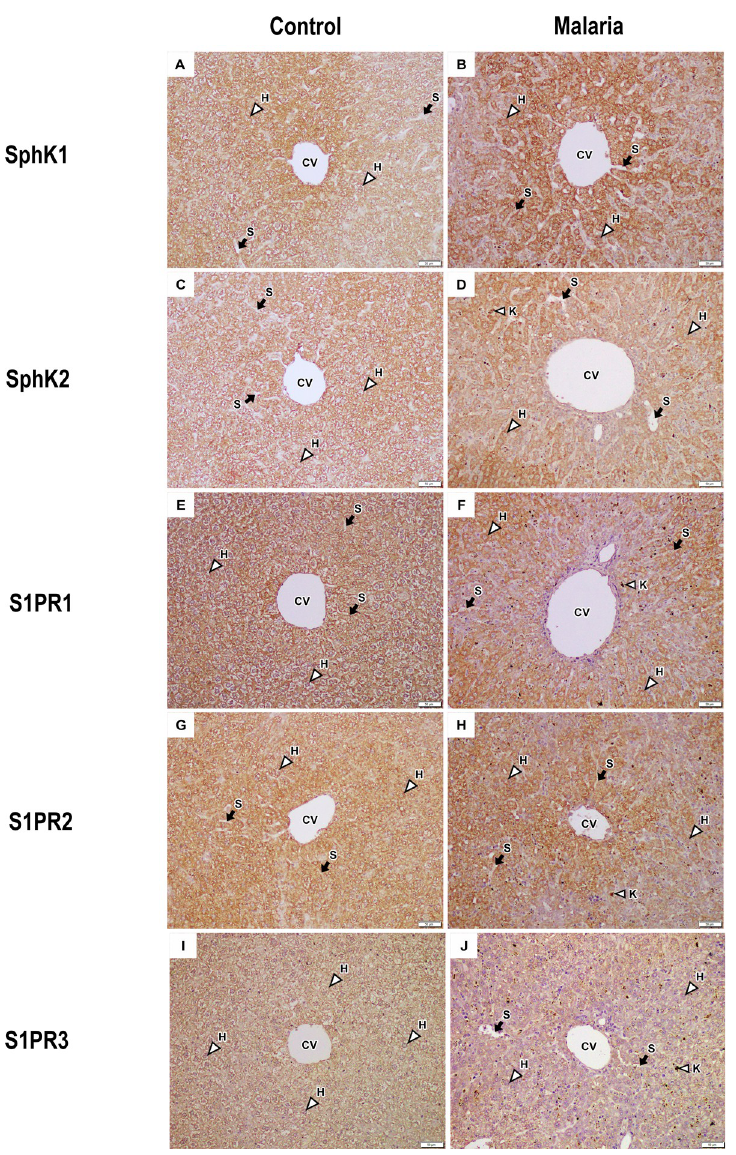
Fig 2. Immunoperoxidase staining for SphK and S1PR in liver tissues from control (A, C, E, G, I) and PbA- infected mice (B, D, F, H, J). Hepatocytes (H), Kupffer cells (K), sinusoids (S), and central veins (CVs). All images are shown at 200 × magnification. Scale bar = 50 μ